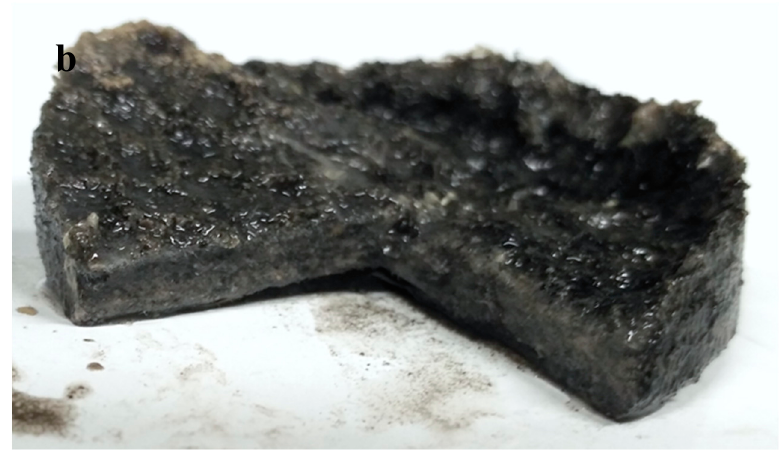
Figure 2. Photos of the clogging materials: ( a ) simulated gravel layer and ( b ) nonwoven geotextile layer.